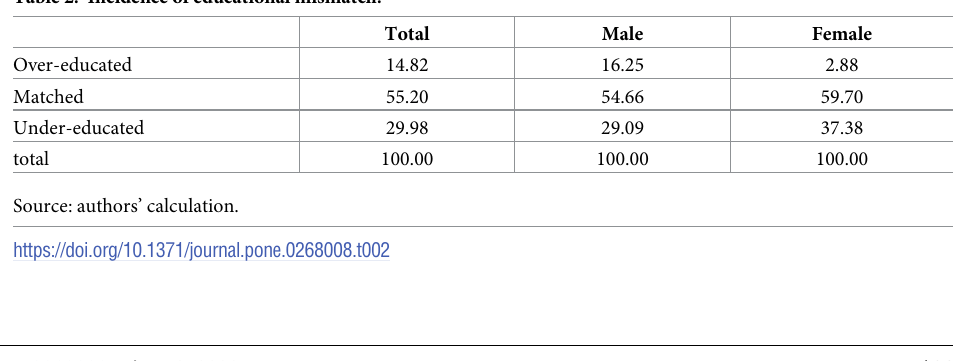
Table 2. Incidence of educational